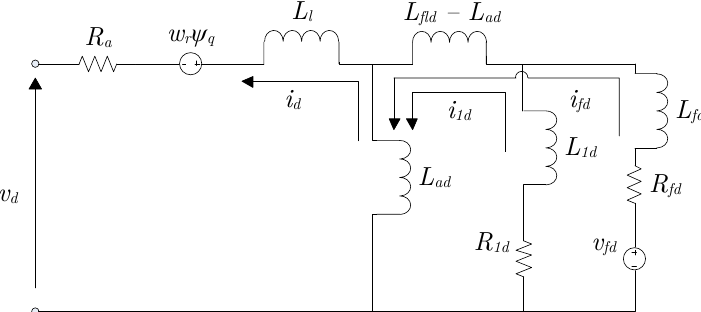
Figure 2. Synchronous machine equivalent electrical circuit: direct axis.